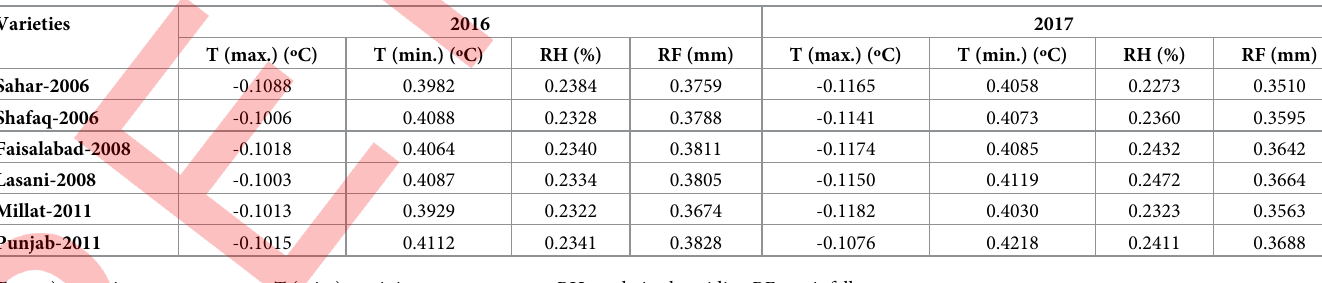
Table 3. Correlation analysis of abiotic factors with aphid population in different wheat